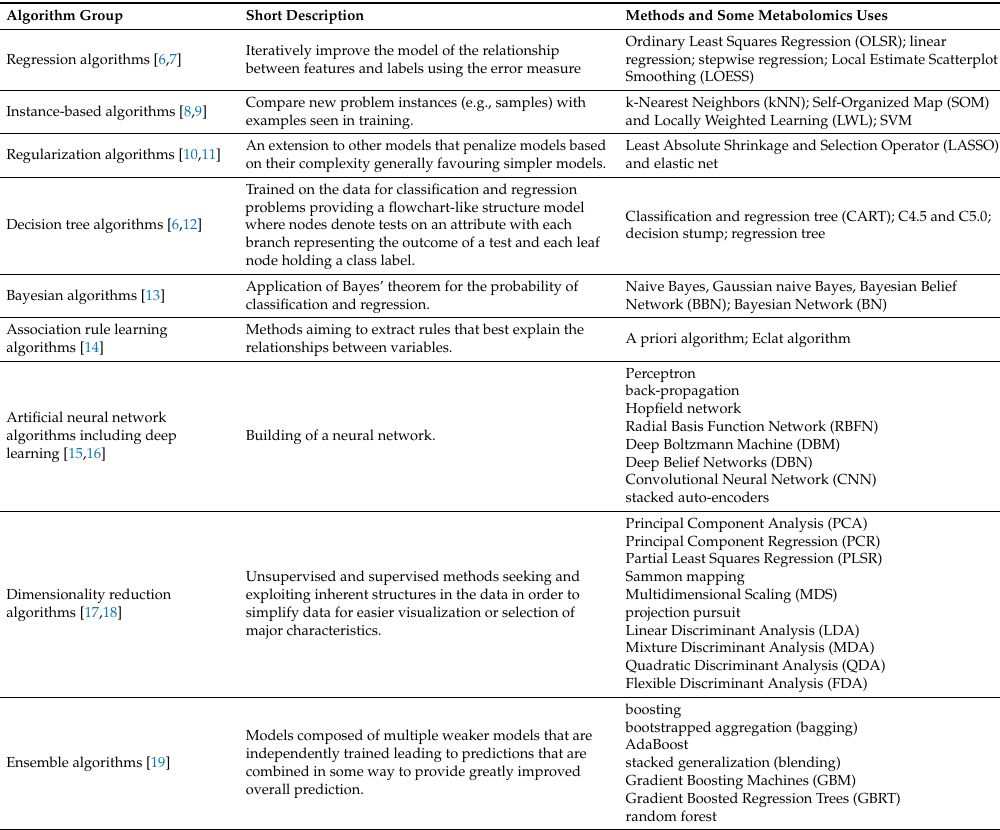
Table 1. Groups of machine learning algorithms based on algorithm similarities. Groups are based on [4,5]. Sample examples of the metabolomics application of methods are provided in the references